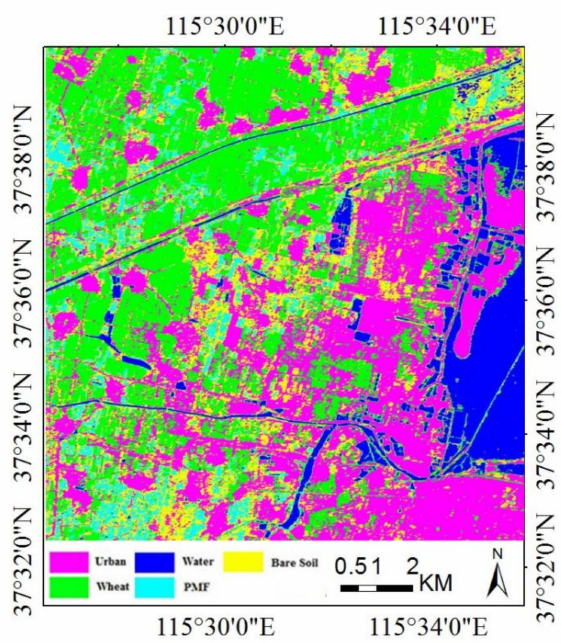
Figure 5. Classification map based on full-polarimetric RADARSAT-2 data.